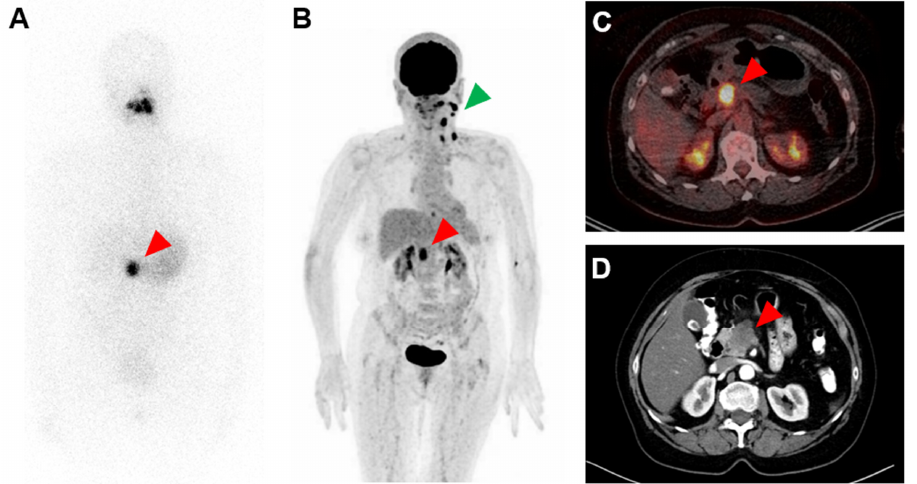
Figure 1. Strongly radioiodine (RAI)-positive and [ 18 F]FDG-positive pancreatic adenocarcinoma. ( A ): 131 I whole-body scintigraphy after administration of 3.8 GBq 131 I, ( B ): MIP (maximum intensity projection) of [ 18 F]FDG PET, ( C ): transversal slice of [ 18 F]FDG PET/CT fusion and ( D ): transversal slice of contrast-enhanced CT. Red arrows point to RAI-positive and [ 18 F]FDG-positive pancreatic adenocarcinoma; green arrow points to RAI-negative and [ 18 F]FDG-positive lymph nodes metastases of papillary thyroid carcinoma in the left neck. Diagnostics 2022 , 12 , x FOR PEER REVIEW